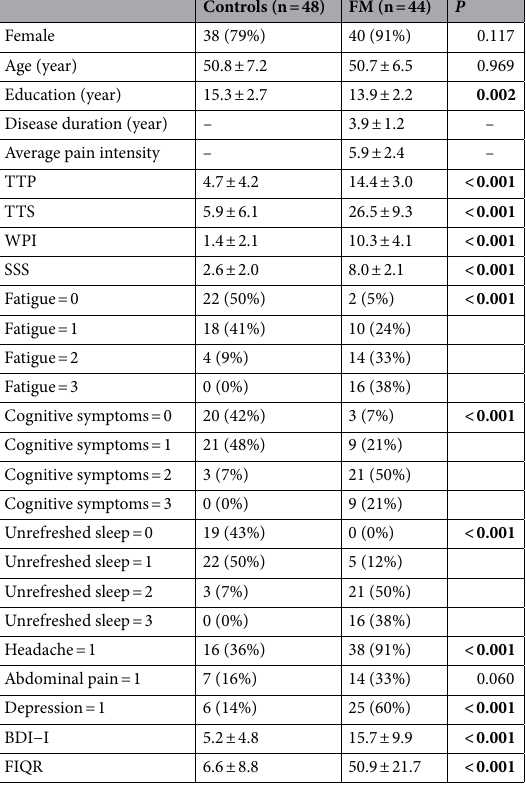
Table 1. Demographics and clinical data. Data are mean ± SD or number (%). FM fibromyalgia, TTP total tender points, TTS total tender point score, WPI widespread pain index, SSS symptom severe score, BDI–I Beck’s Depression Inventory version 1, FIQR Revised fibromyalgia impact questionnaire.